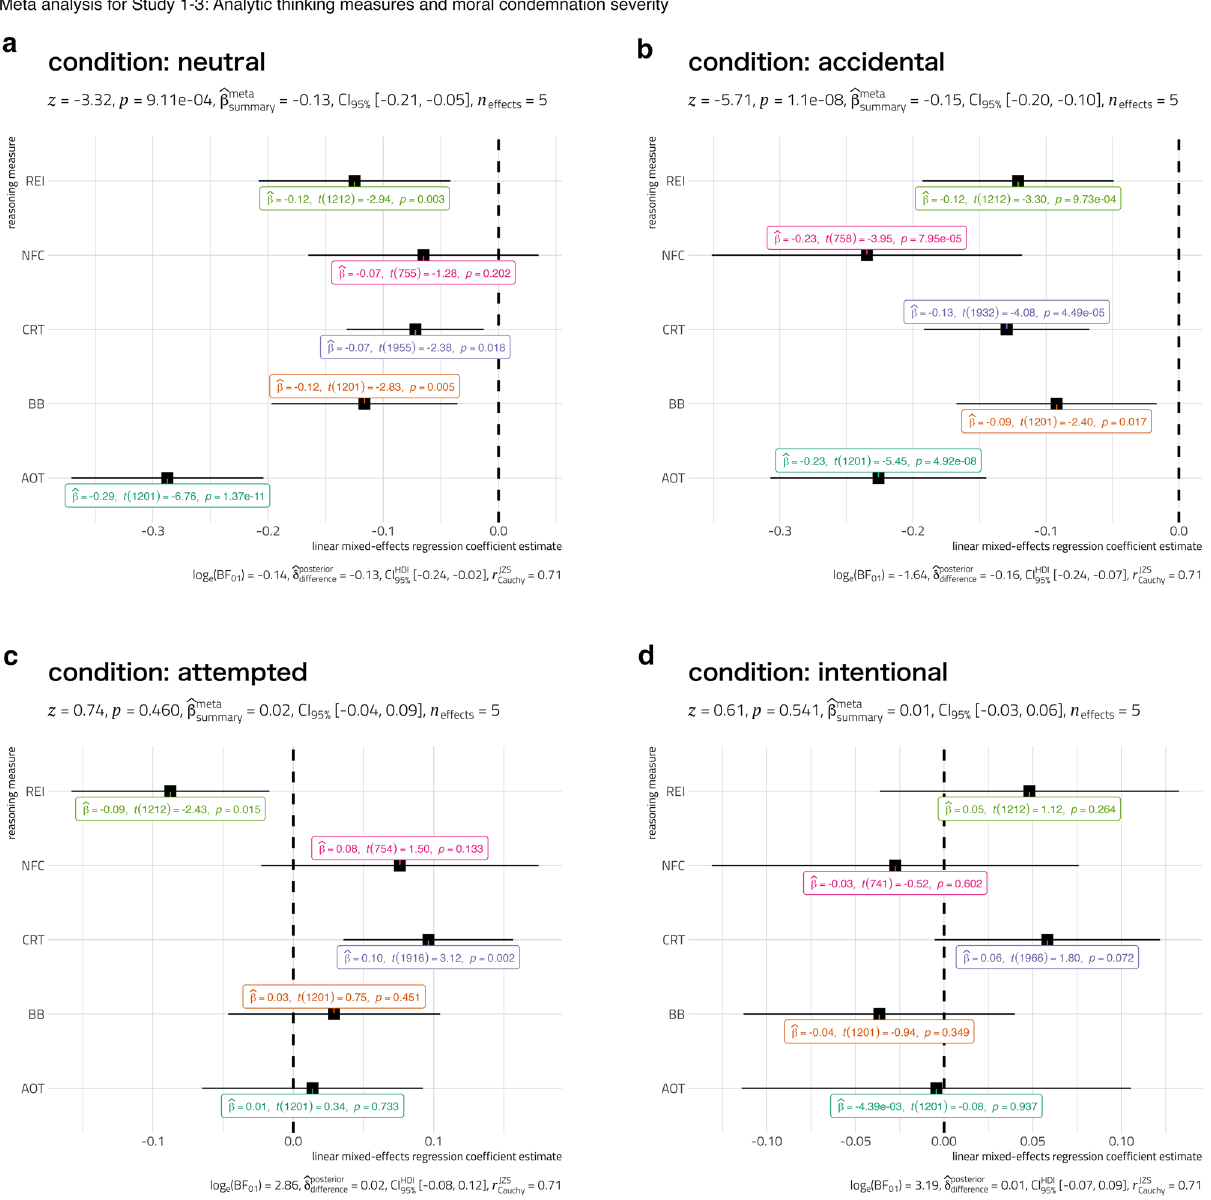
significantly and consistently different from 0 across measures only for accidental harm condition. Error bars indicate 95% confidence intervals. Results from frequentist random-effects meta-analysis are shown in the subtitle, while results from Bayesian random-effects meta-analysis are shown in the caption. Although the meta- analytic effect is significant for neutral and accidental condition, Bayes Factor for the neutral condition reveals that the evidence in favor of the alternative hypothesis was inconclusive (BF 10 = 1.15), while it was substantial for the accidental harm cases